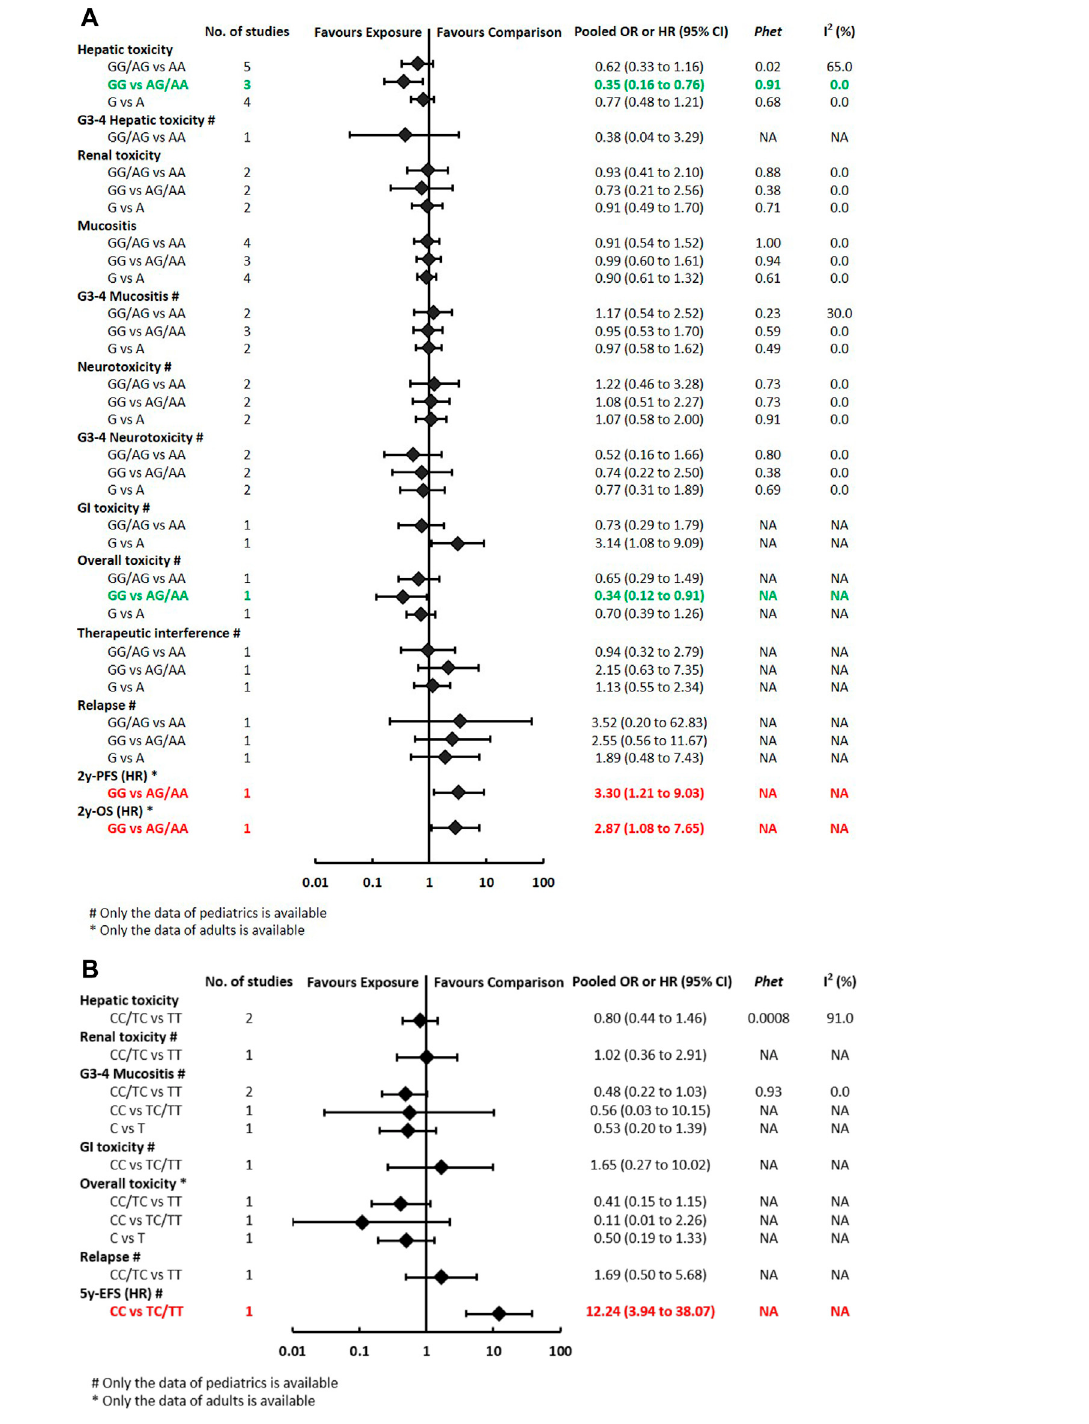
Frontiers in Pharmacology |